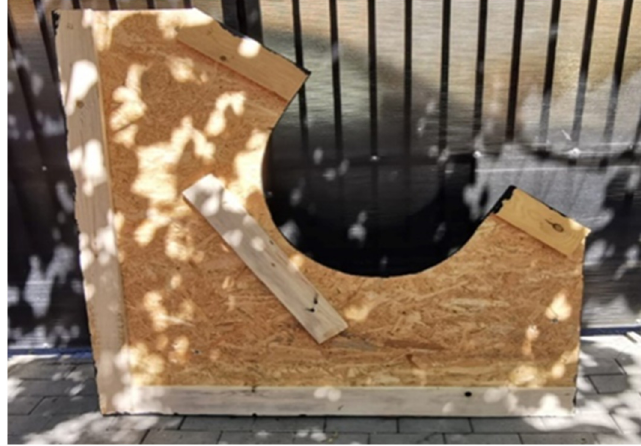
Figure 2. Rigid support manufactured from OSB board.